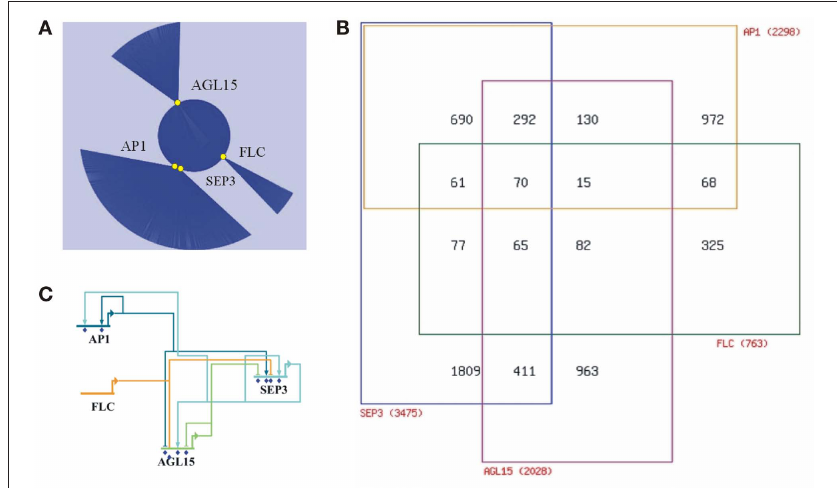
Figure 1 | integrative analysis of the reported target genes of the MADS proteins SeP3, AP1, AgL15, and FLC. (A) Network representation (Cytoscape) of the reported target genes (represented by blue lines) of the four MADS proteins (yellow circles). (B) Venn diagram depicting the numbers of shared target genes. The four MADS proteins share 70 target genes. (C) Wire diagram (BioTapestry) showing the complex regulatory network between the four MADS proteins themselves. MADS genes are MADS targets and autoregulatory feedback loops are